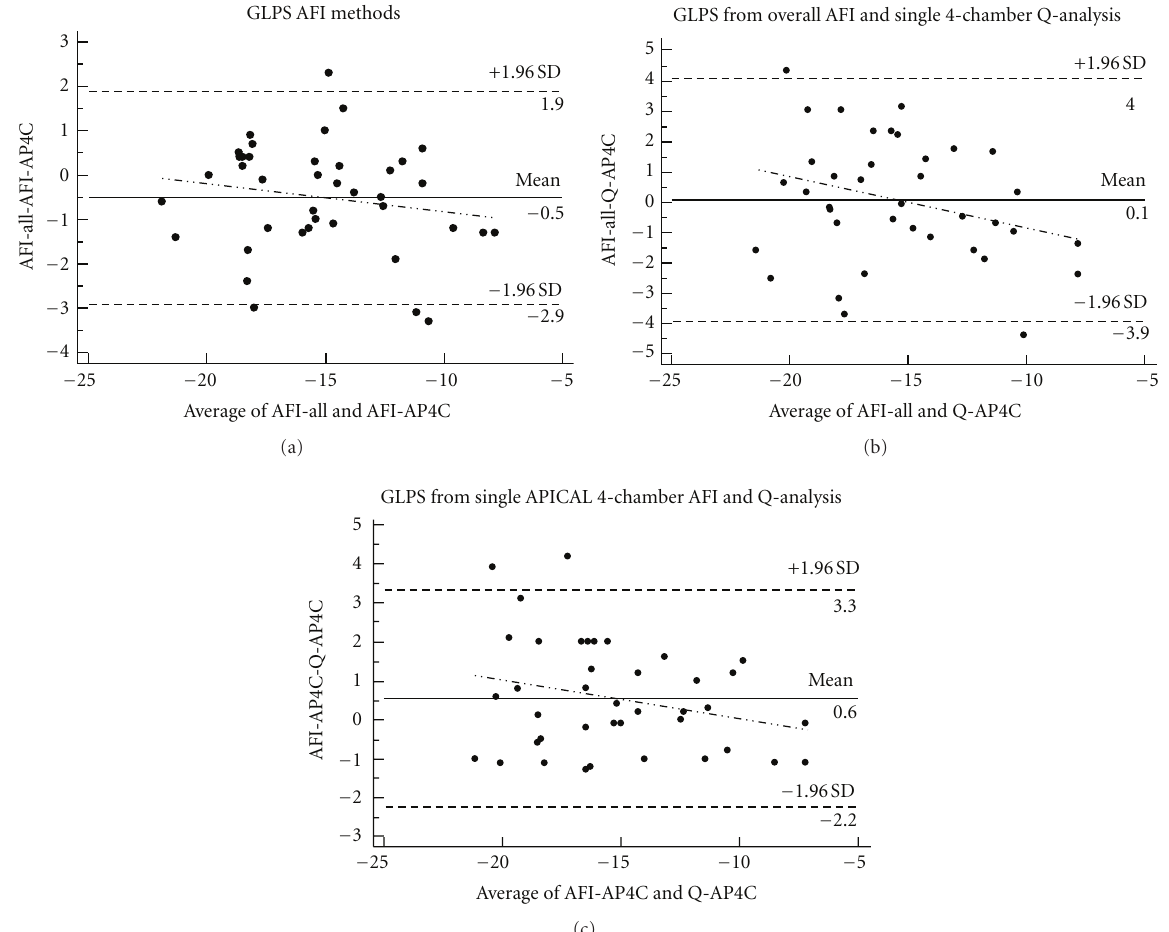
Figure 2: Bland Altman plot with mean di ff erence and limits of agreement between overall averaged global peak systolic strain (aGLPS) of the AP4C, AP2C, and APLAX views using AFI method (AFI-All) compared to single apical 4-chamber GLPS using AFI method (AFI-AP4C) (a), AFI-all compared to single apical 4-chamber view using conventional Q-analysis (Q-AP4C) (b), and GLPS comparing AFI of an apical single 4-chamber view (AFI-AP4C) and Q-analysis of an apical single 4-chamber view (Q-AP4C) (c).